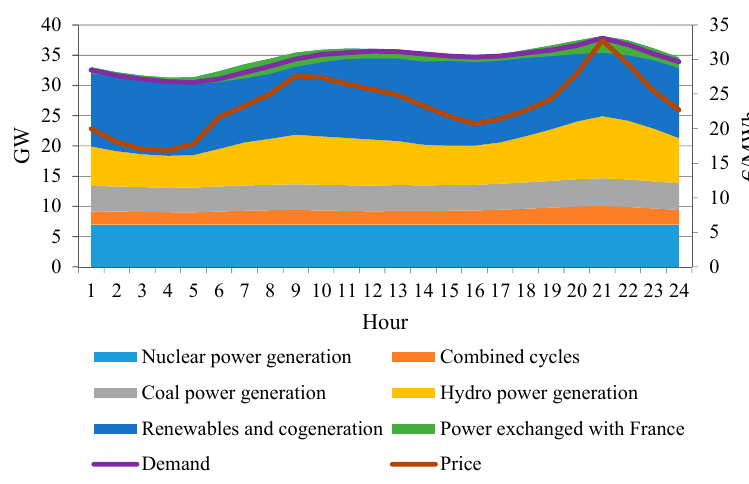
Figure 4. Hourly mean electricity generation, demand and real price of electricity in April 2016.